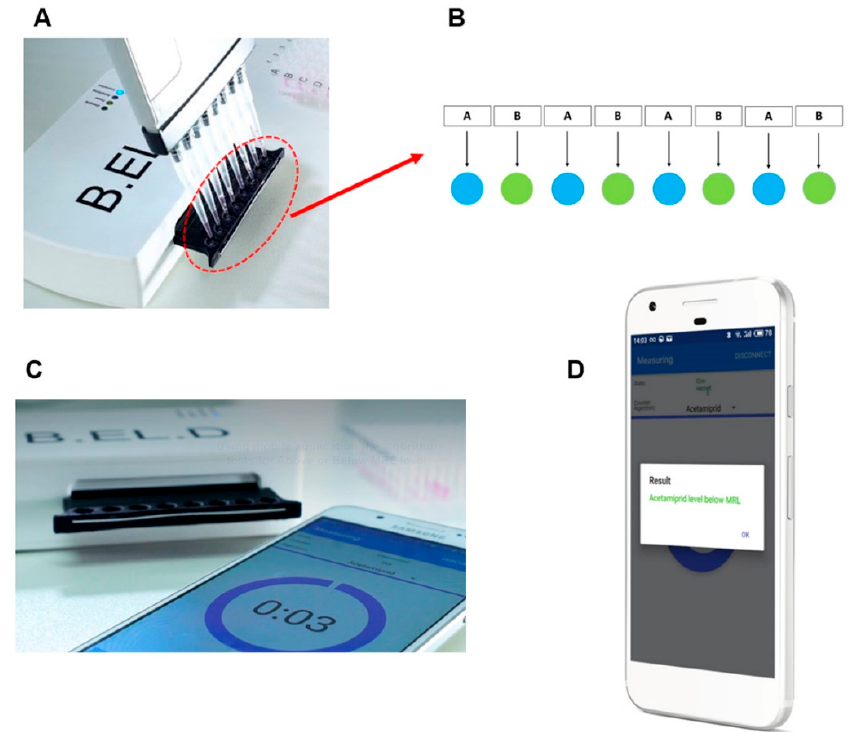
Figure 1. ( A ) Use of multichannel automated pipette for the addition of (i) 36 µ l of cells and then Figure 1. (A) Use of multichannel automated pipette for the addition of (i) 36 μ l of cells and then (ii) (ii) 4 µ l of samples on the electrode surface. ( B ) Arrangement of cells on the electrode surface (A: 4 μ l of samples on the electrode surface. (B) Arrangement of cells on the electrode surface (A: non-engineered cells, B: engineered cells). ( C ) Device connected with smartphone and measurement non − engineered cells, B: engineered cells). (C) Device connected with smartphone and measurement start. ( D ) The result appears on the smartphone start. (D) The result appears on the smartphone screen.